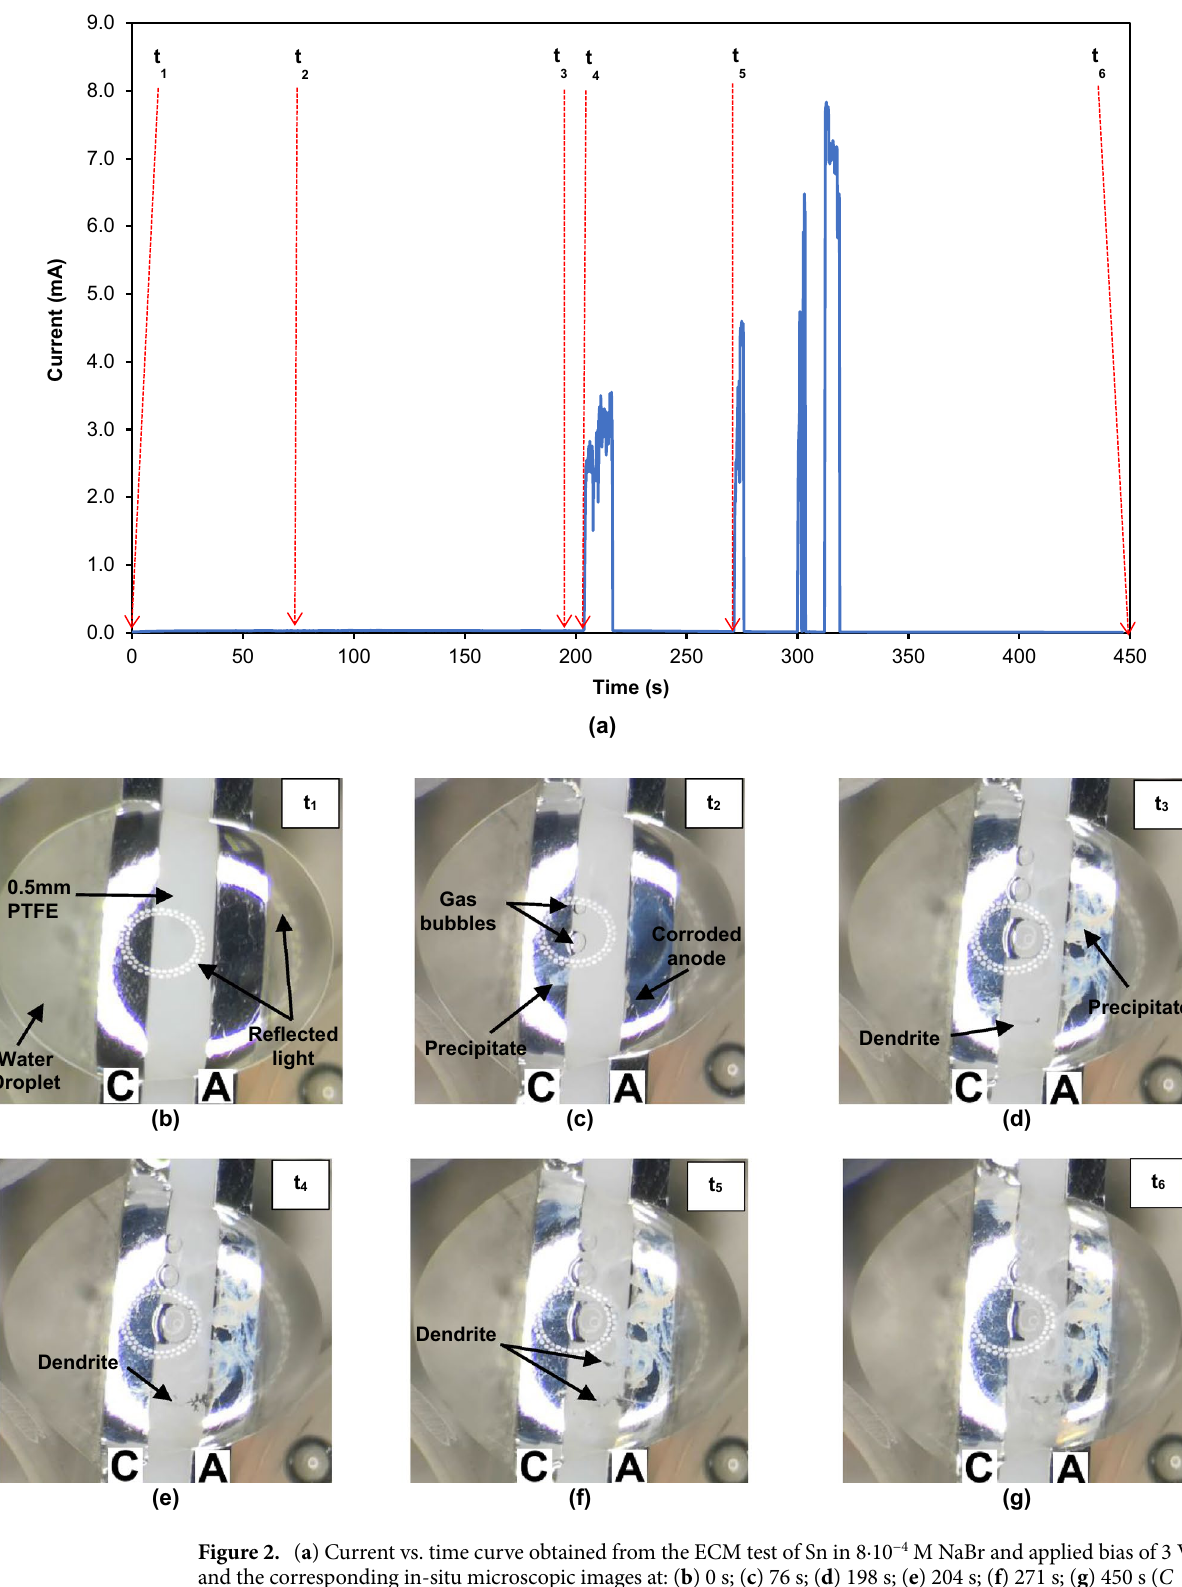
Figure 2. ( a ) Current vs. time curve obtained from the ECM test of Sn in 8·10 −4 M NaBr and applied bias of 3 V and the corresponding in-situ microscopic images at: ( b ) 0 s; ( c ) 76 s; ( d ) 198 s; ( e ) 204 s; ( f ) 271 s; ( g ) 450 s ( C cathode; A